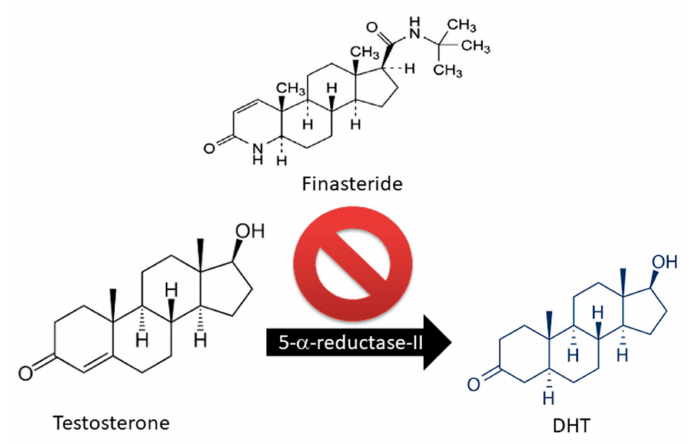
Figure 2. Finasteride action on Testosterone metabolism: block of 5-alpha reductase activity.